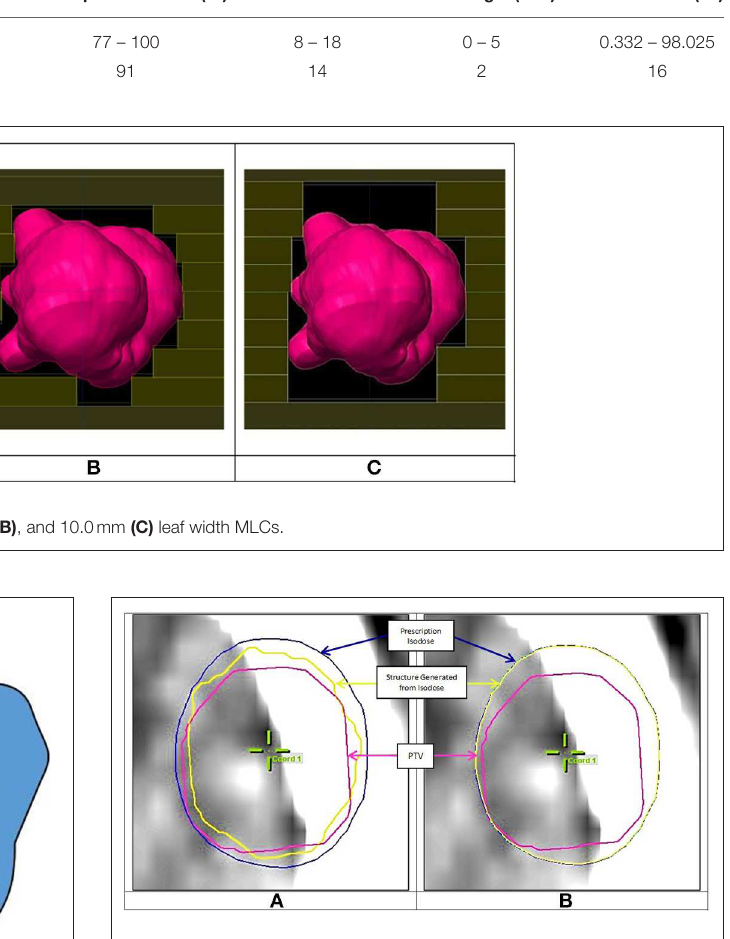
The evaluation of terms V isod and V ∩ in Equation